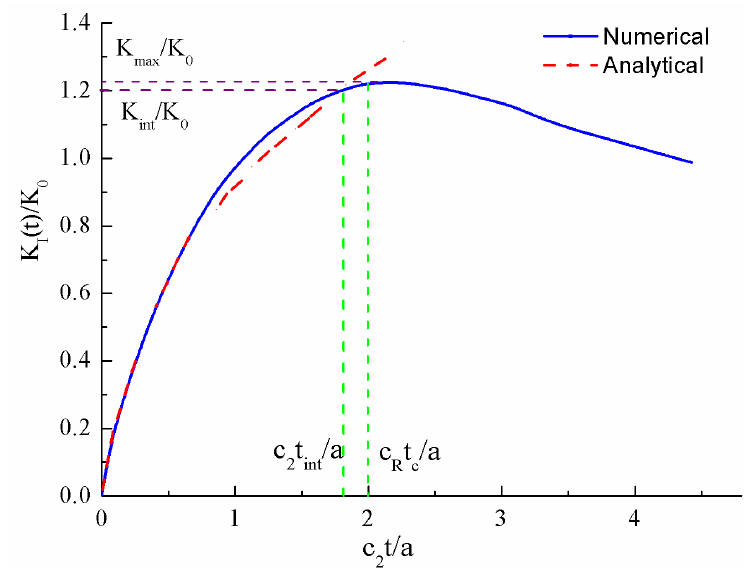
Figure 2. Dynamic stress intensity